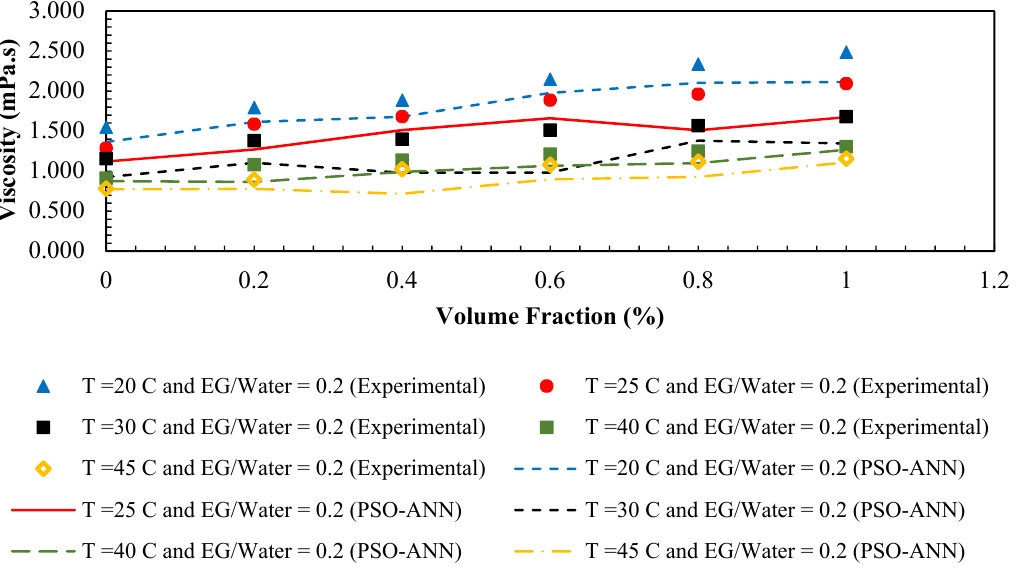
Figure 13. Absolute relative error distribution of the obtained outputs from PSO-ANN model versus corresponding viscosity of (cid:1832)(cid:1857) (cid:2870) (cid:1841) (cid:2871) /ethylene glycol ‐ water nanofluid data points.